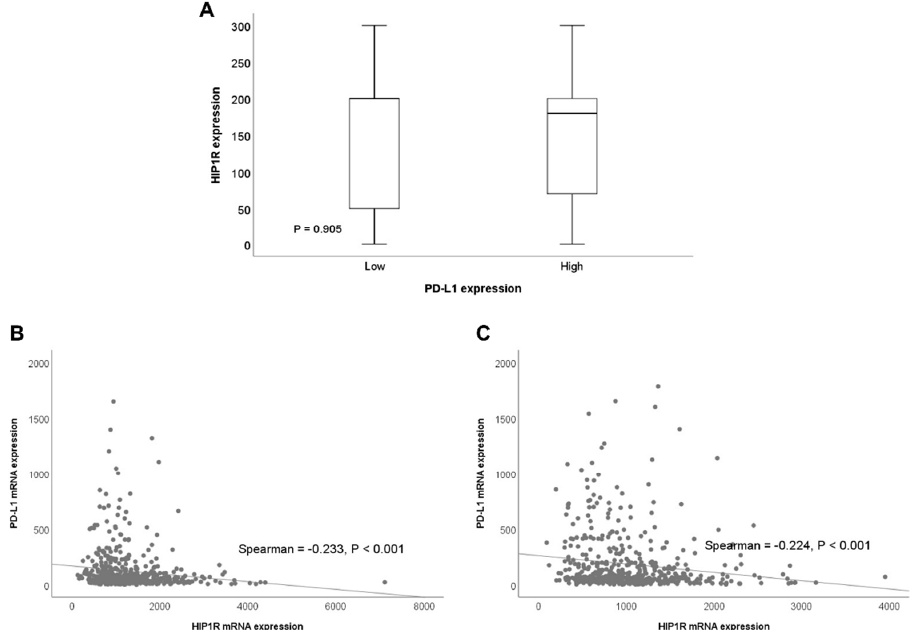
Figure 2. Correlation analyses involving Huntingtin-interacting protein 1-related protein (HIP1R) and programmed death-ligand 1 (PD-L1) expression. ( A ) Correlation between HIP1R and PD-L1 detected immunohistochemically. ( B ) Correlation between HIP1R and PD-L1 mRNA expression in lung adenocarcinoma. ( C ) Correlation between HIP1R and PD-L1 mRNA expression in lung squamous cell